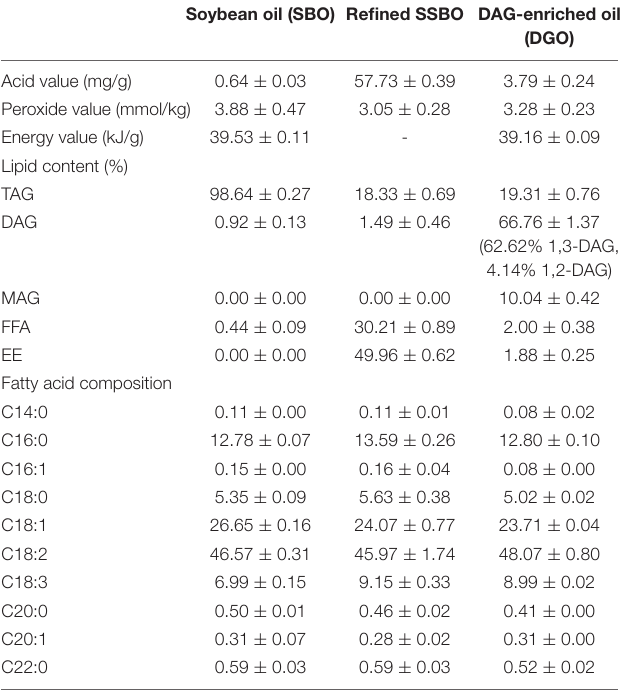
TABLE 3 | Physicochemical and compositional characterization of DAG-enriched oil.